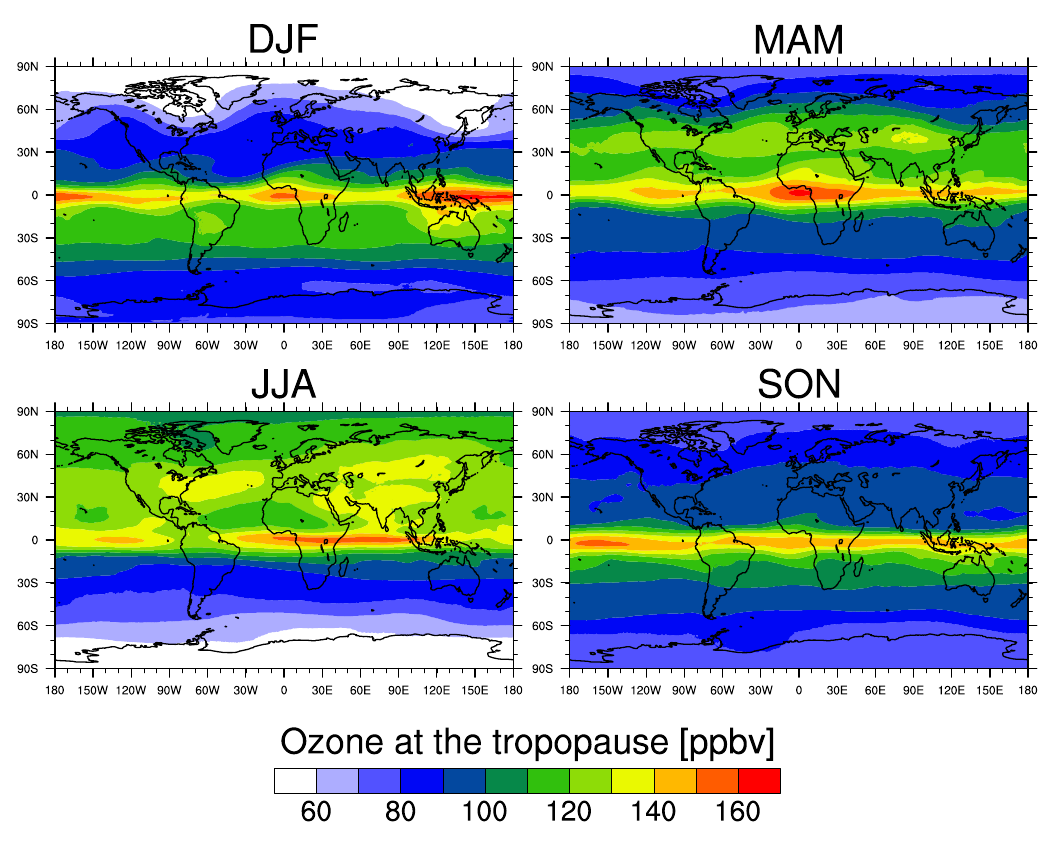
Fig. 14. Seasonally averaged ozone mixing ratios per volume (ppbv) at the 2pvu/380K dynamical tropopause for